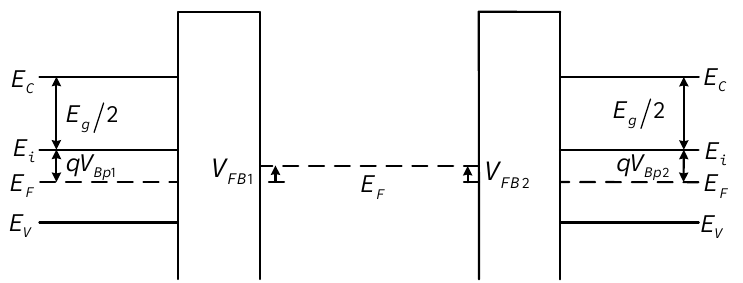
Figure 2. High-frequency capacitance – voltage curve of the upper or lower MIS structure in the stacked bonding structure.